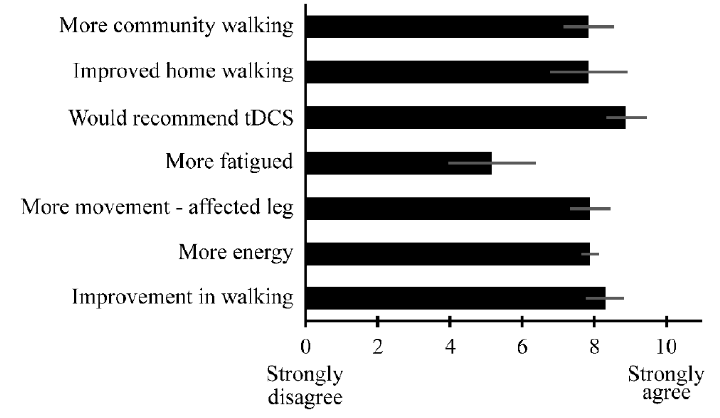
Figure 2. Perceived benefits and detriments of tDCS. Ratings are from a 0–10 scale. All questions assessed potential benefits of tDCS, except for feeling “more fatigued,” which assessed a potential detriment of tDCS. See Appendix A for questions. Bars are average, and error bars are standard error.